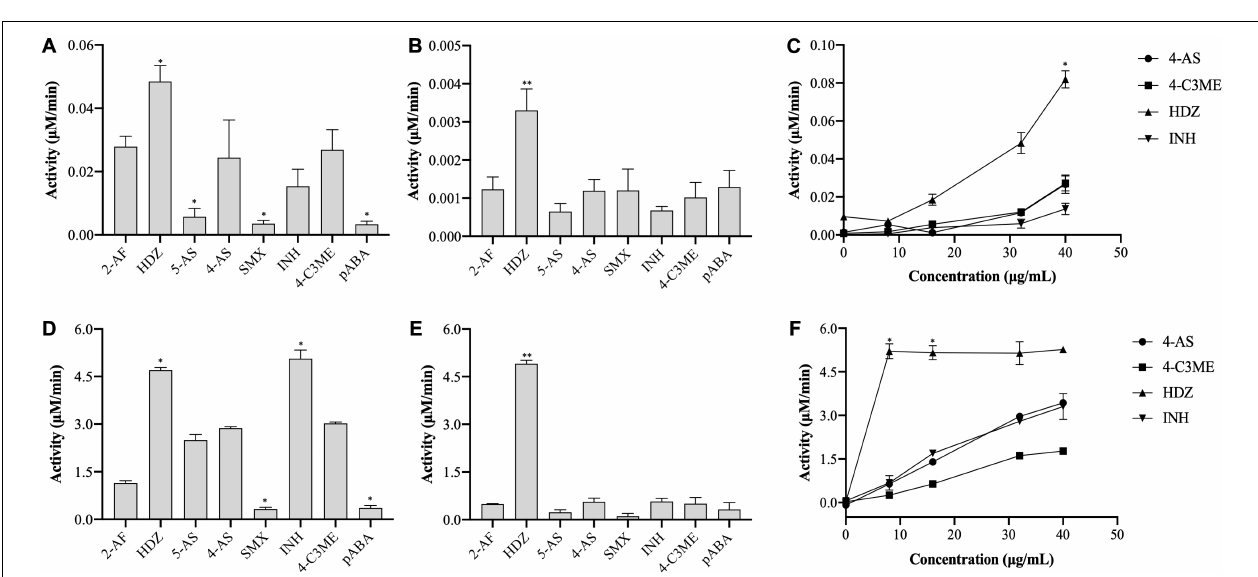
FIGURE 3 | Enzyme activity of (VIBVN)NAT. (A–C) The activity of NAT was detected by the PNPA method at (A) 40 µ g/mL and (B) 5 µ g/mL. (C) A total of 8–40 µ g/mL of the enzyme was mixed with 2 mM PNPA and 500 µ M acetyl acceptors in 25 mM Tris–HCl buffer (pH 7.5). (D–F) The activity of NAT was detected by the DTNB method at (D) 40 µ g/mL and (E) 5 µ g/mL. (F) A total of 8–40 µ g/mL of the enzyme was mixed with 500 µ M AcCoA and 500 µ M acetyl acceptors in 25 mM Tris–HCl buffer (pH 7.5). The data are presented as the mean ± SD of three independent experiments. Error bars indicate SD values. The results